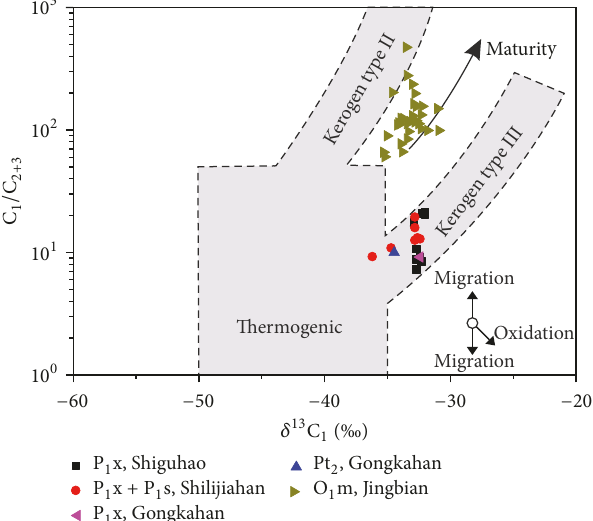
Figure7:ModifiedBernarddiagramoftightgasfromtheHangjinqi area (modified after Bernard et al. [40]). Data of the O 1 m gas in the Jingbian gas fields are from Dai